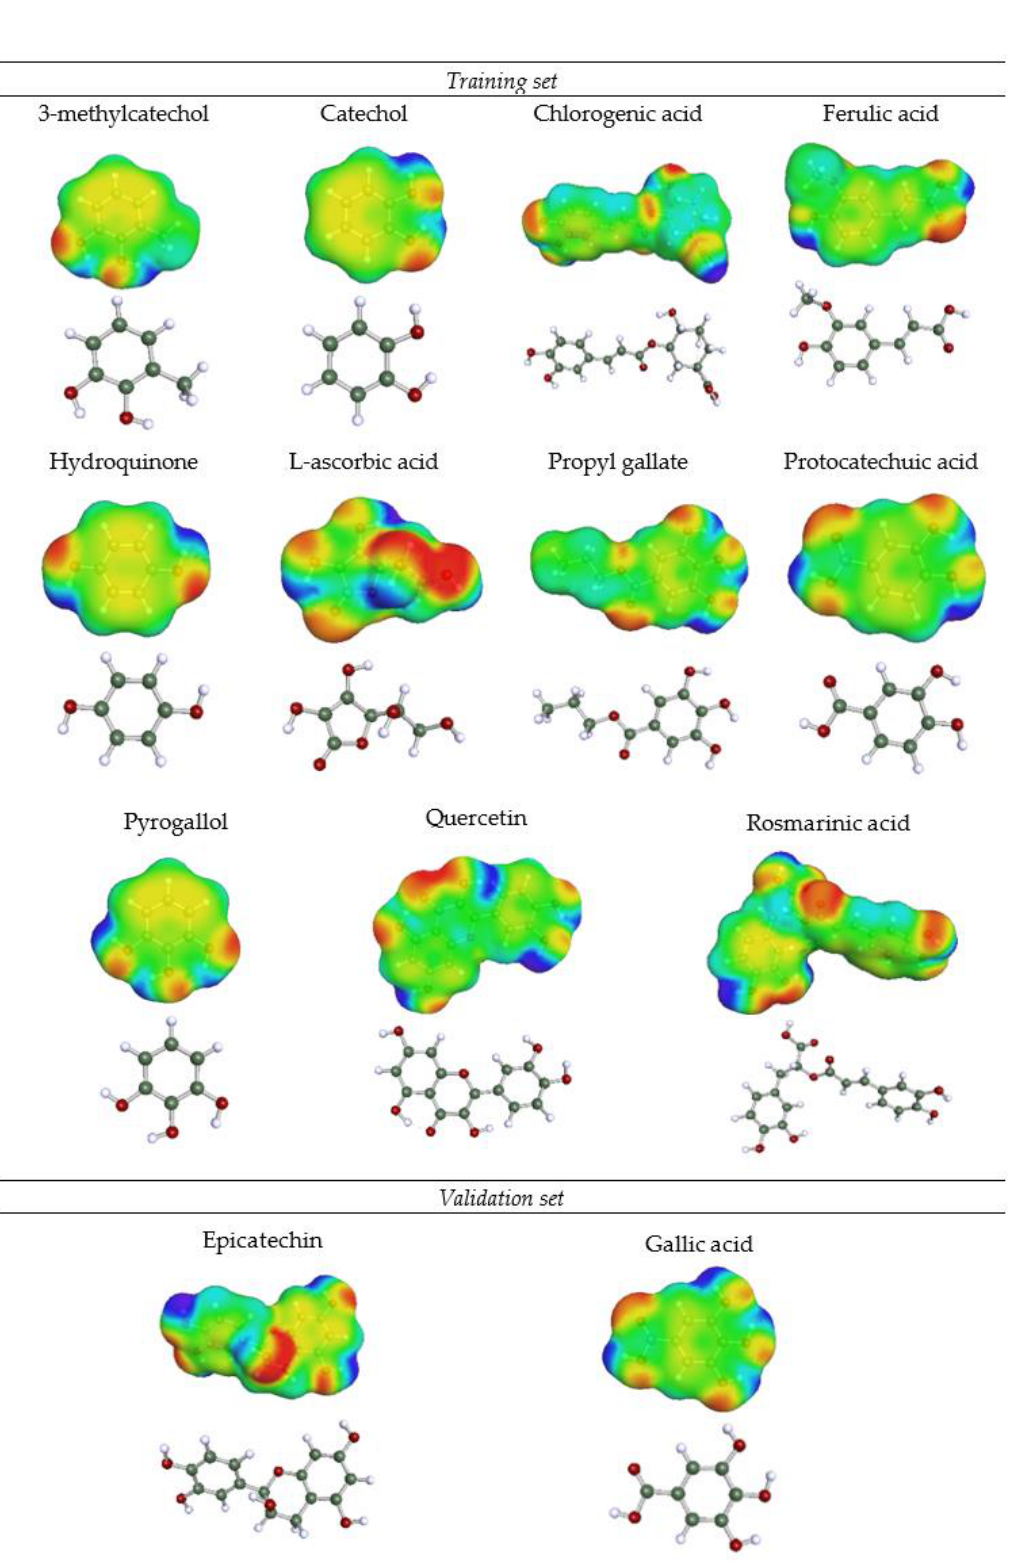
Figure 3. 3D molecular structures of the compounds used in this work and their charge density (electronegative zone in red, electropositive zone in blue and neutral zone in green).